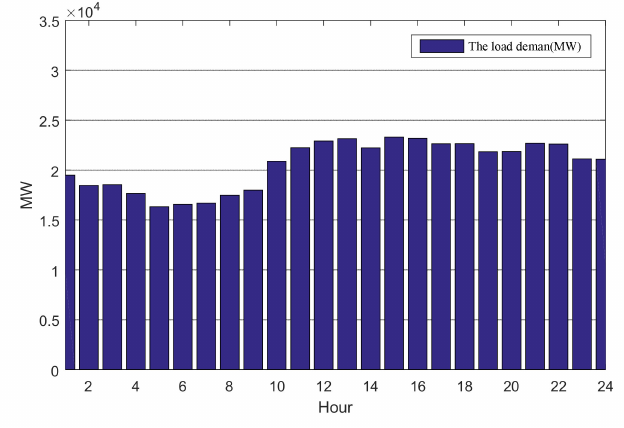
Figure 2. Load demand in non-summer.